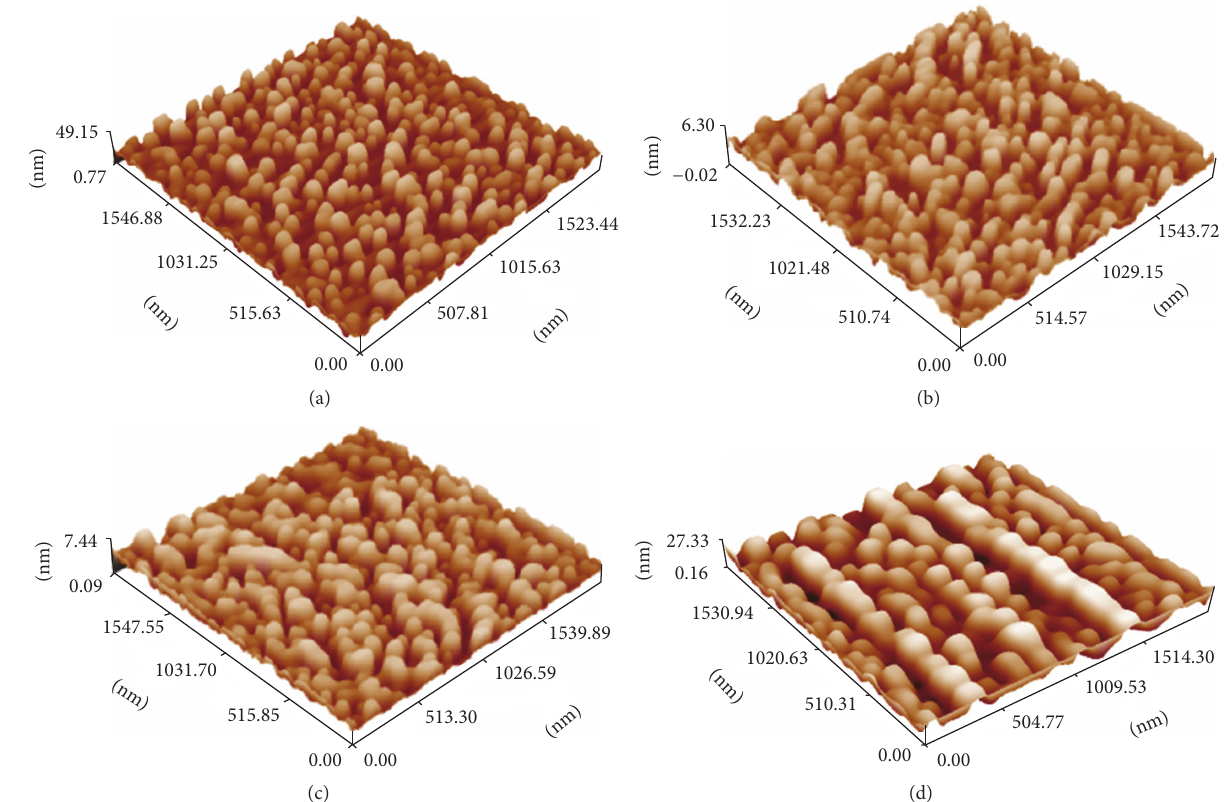
Figure 7: AFM images for Ag for (a) 700 mJ, (b) 720 mJ, (c) 740 mJ, and (d) 760 mJ.